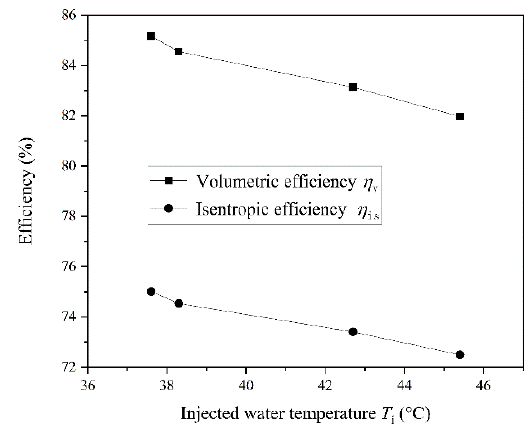
Figure 11. Compressor efficiencies under different injected water temperature.